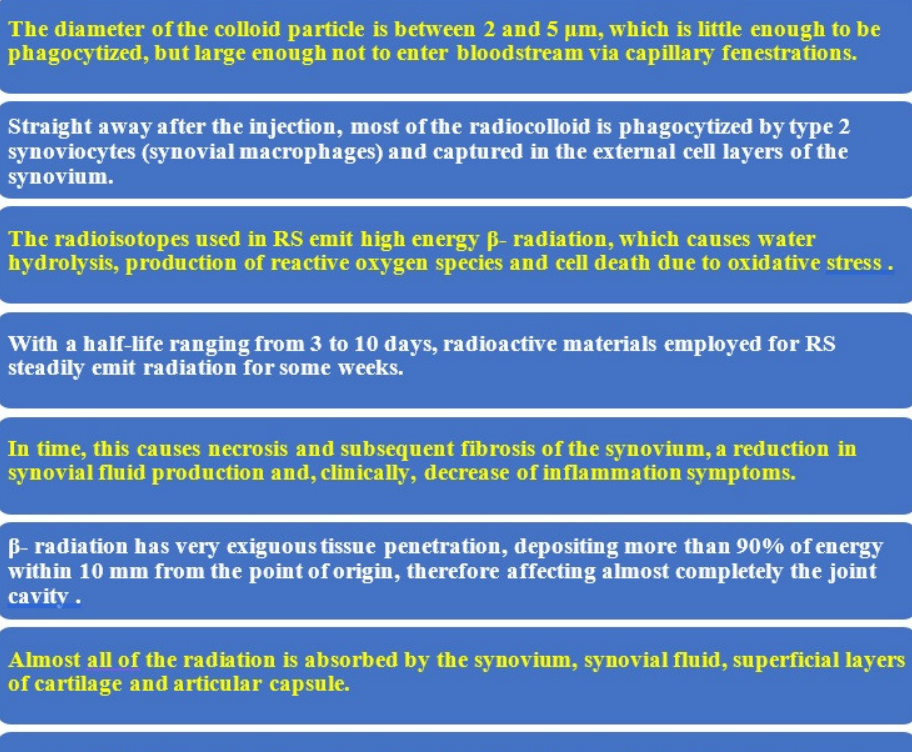
Figure 1. Mechanism of action of radiosynovectomy (RS).